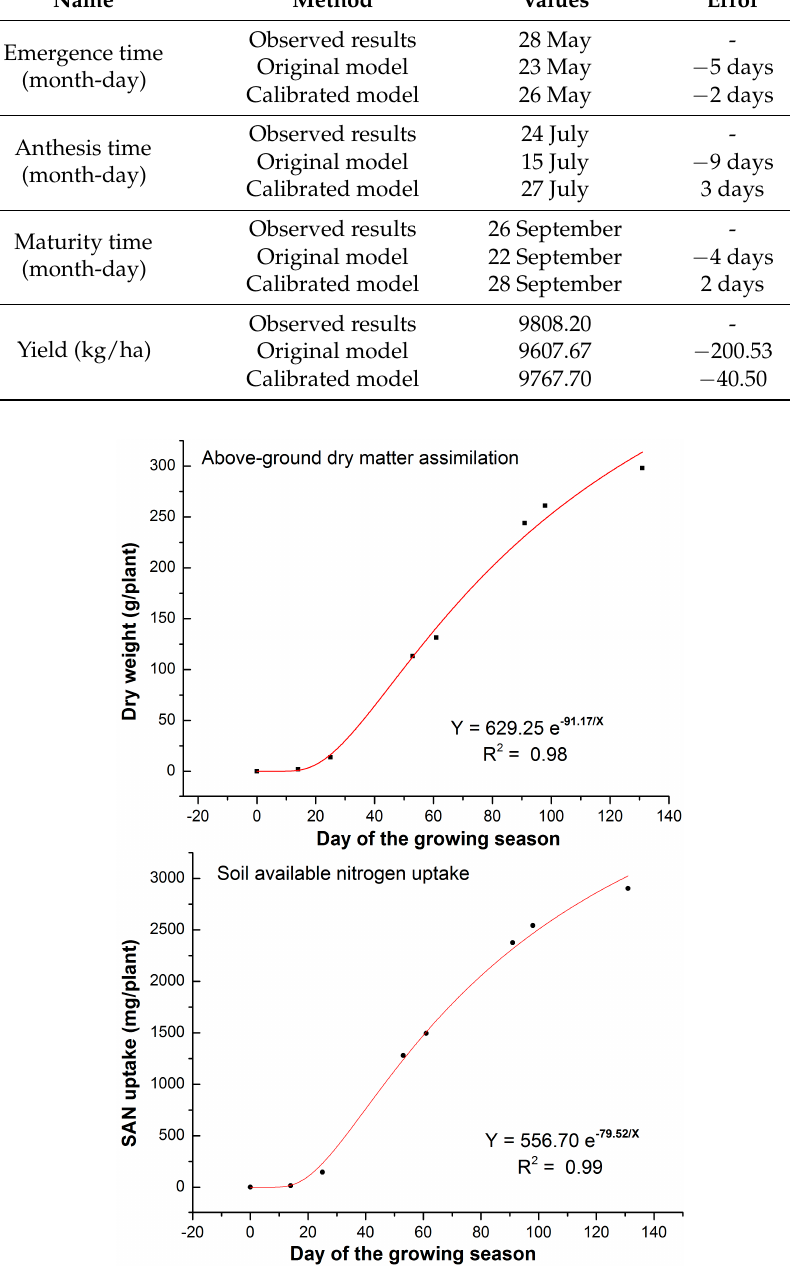
Figure 4. Analysis results of biomass and soil available nitrogen uptake simulation.